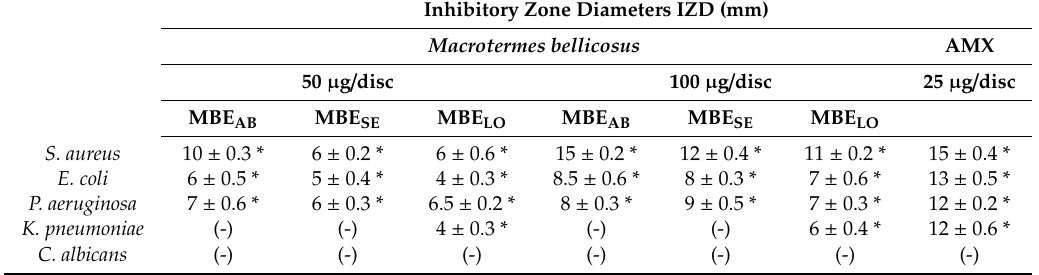
Table 2. Inhibitory zone diameters (IZD) of ethanolic M. bellicosus extracts (soldier caste ) collected in Abomey-Calavi (MBE AB ), Sekou (MBE SE ) and Lokossa (MBE LO ), Republic of Benin, compared to amoxicillin (AMX). Data are presented as mean ± SEM obtained from a compilation of four independent experiments done in triplicate. * p < 0.001 vs. untreated control. (-) means “no